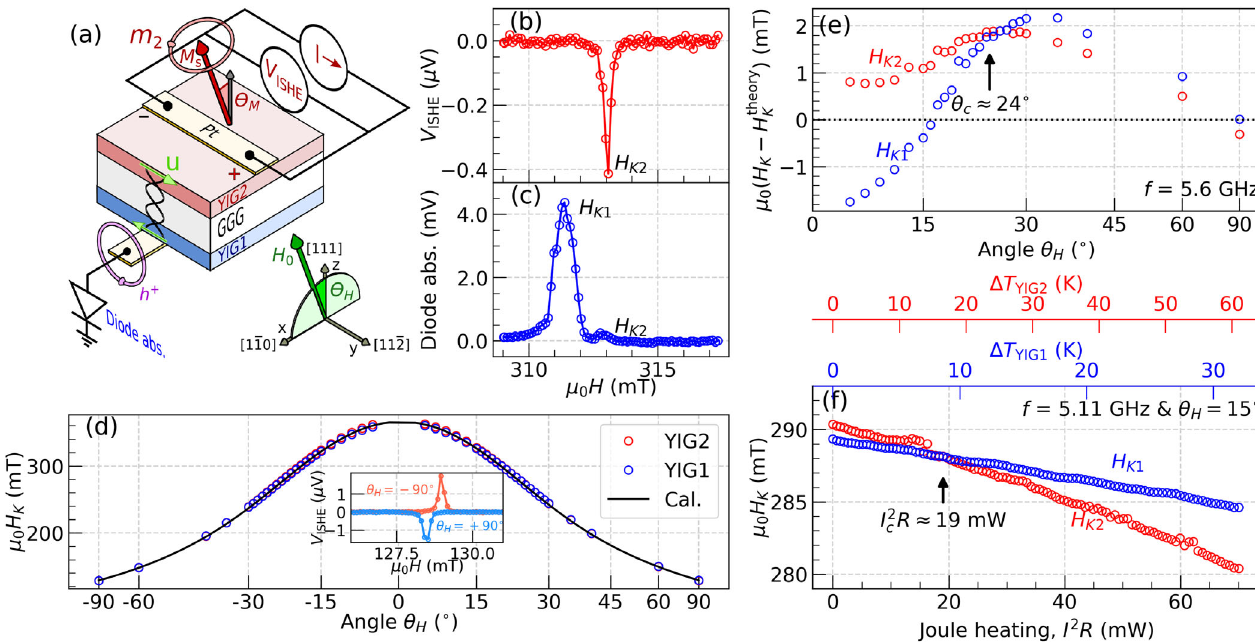
FIG. 2. Spin-pumping experiment on a YIG 1 j GGG j YIG 2 stack. (a) Schematic setup: A 300 - μ m-wide strip line antenna at the bottom couplesinductivelytothe magneticlayers.A Ptstripdepositedontopofthestackmonitorsthedynamicsofthetop(YIG2)layer.Adccurrent I in the same Pt wire generates a temperature gradient by Ohmic heating. (b) Spin-pumping voltage across the Pt ( V ) and (c) microwave ISHE diode absorption signal. The peaks of (b) and (c) represent the Kittel resonances of YIG2 ( H K 2 ) and YIG1 ( H K 1 ), respectively. Both spectra are taken at a polar angle θ H ¼ þ 17 °. (d) θ H dependence of the resonance fields of both layers. The solid line is a fit of H K 2 ð θ H Þ by the Kittel signal changes sign when rotating the magnetic field by 180°, as shown in the inset [50]. formula H theory K (see Appendix B). The V ISHE (e) Difference betweenobserved and calculated resonance fields asa functionof θ H . At the angle θ c ≈ 24 °, the resonancescross.(f) Variation of H K 1 and H K 2 asa functionofJoule heatingpower in the Ptstrip. The arrow indicates the Joule heatingat which the detuningvanishes. The axes on top show the temperature rise of YIG1 and YIG2 deduced from the magnetizations as derived from the reduced resonance fields. Microwave power settings are as follows: 6 dBm for (b) – (e) and 0 dBm for (f), which is at the antenna resonance